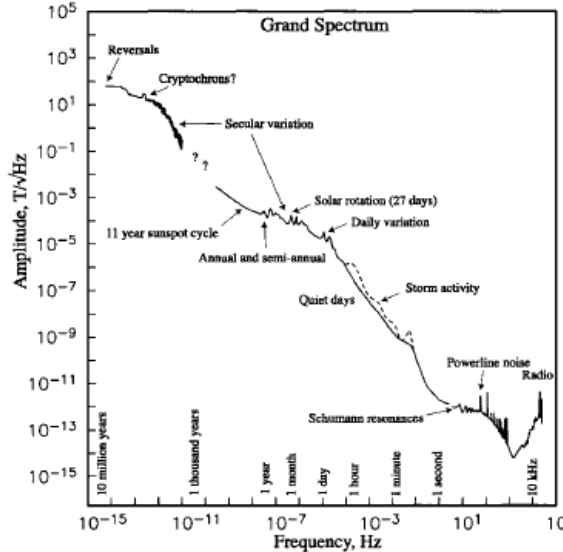
Figure 1. Power spectra of the variations of the geomagnetic field (adopted from Constable and Constable [2004]).